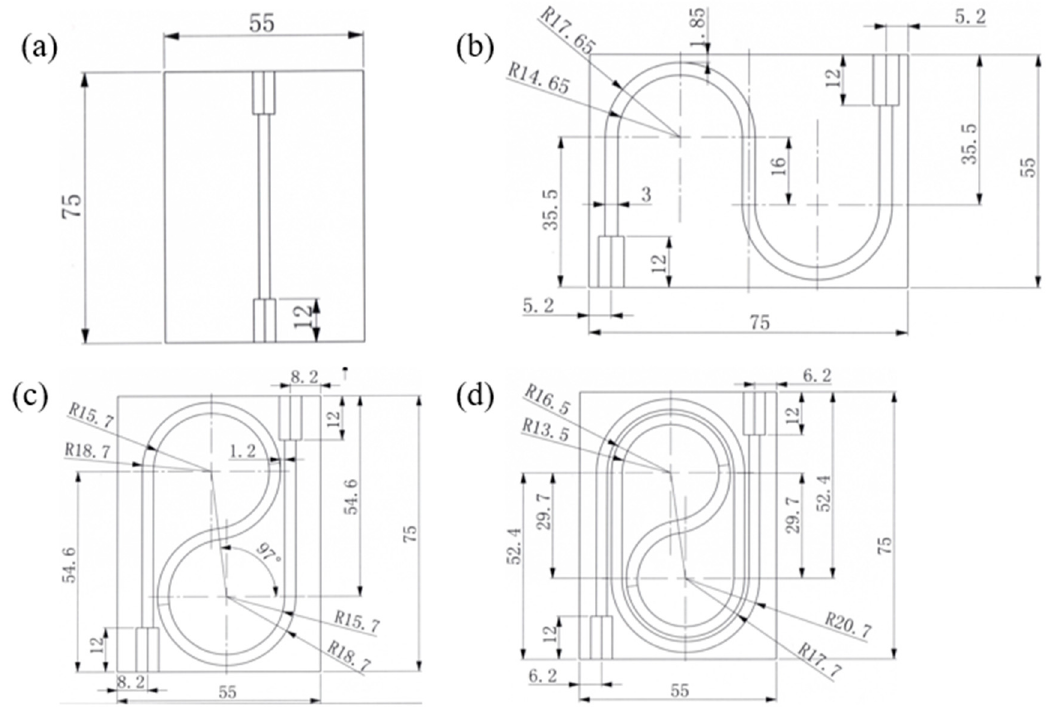
Figure 1. Detailed design of the module substrates: ( a ) straight, ( b ) two semicircle, ( c ) one circle, and ( d ) two circles. (Unit: mm).